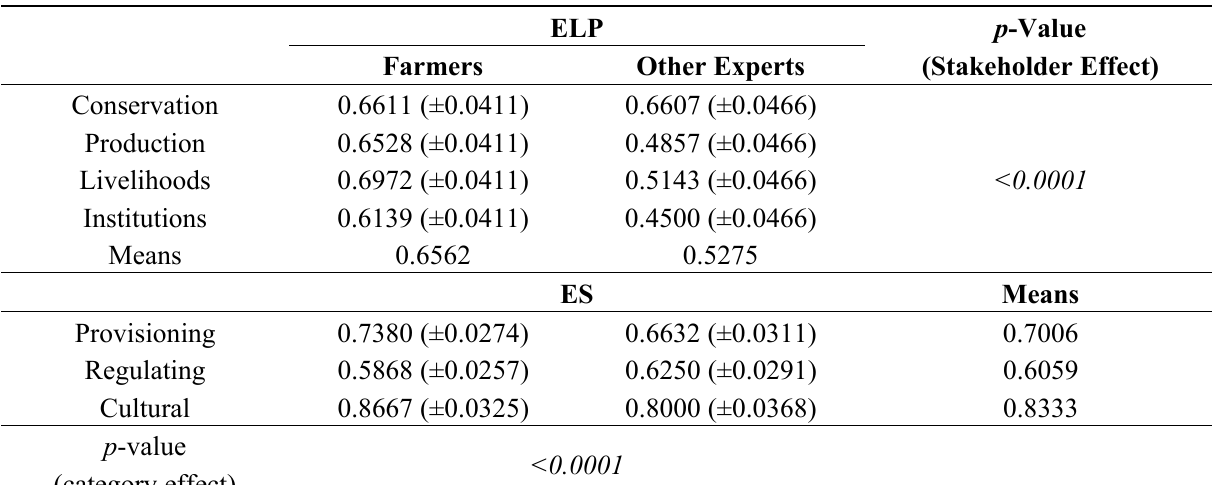
Table 4. Means of ELP and ES sub-index values at the KZN site (standard deviation in brackets). ES, Ecosystem Services; ELP, Ecoagriculture Landscape Performance; KZN, KwaZulu-Natal.